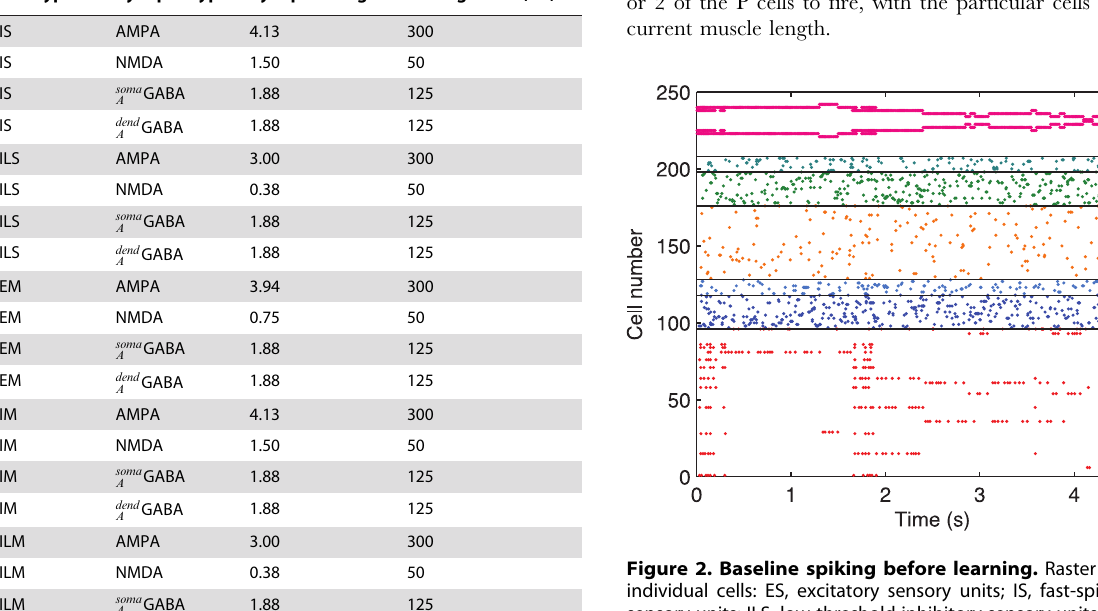
Results Average spiking rates (in Hz) were: P, 1.9; ES, 0.4; IS, 4.4; ILS, 2.9; EM, 0.5; IM, 4.3; and ILM, 3.1, in the absence of learning and the presence of babble noise (Fig. 2). Inhibitory cells fired faster than excitatory cells, consistent with observed rates in cortex. The top units in Fig. 2 represent the proprioceptive (P) inputs from the flexor and extensor muscles. Each of the 2 muscles stimulates 1 or 2 of the P cells to fire, with the particular cells depending on current muscle length.